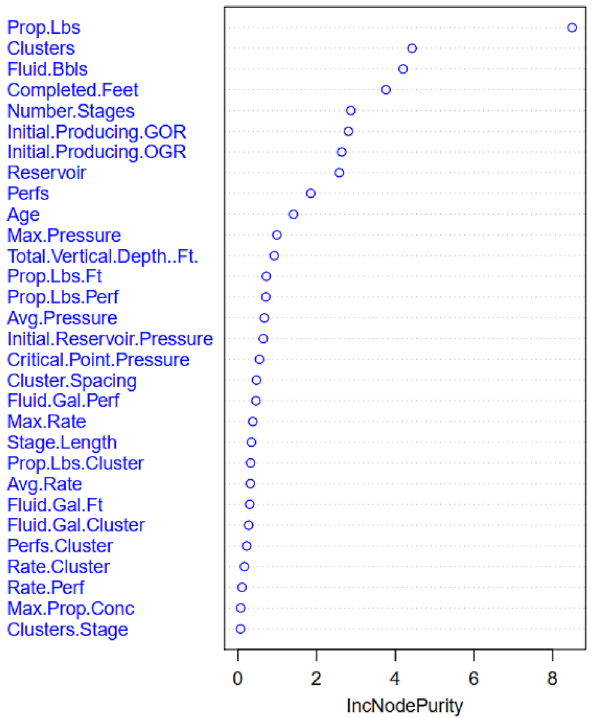
Fig. 1 The first measure of importance calculated from regression trees